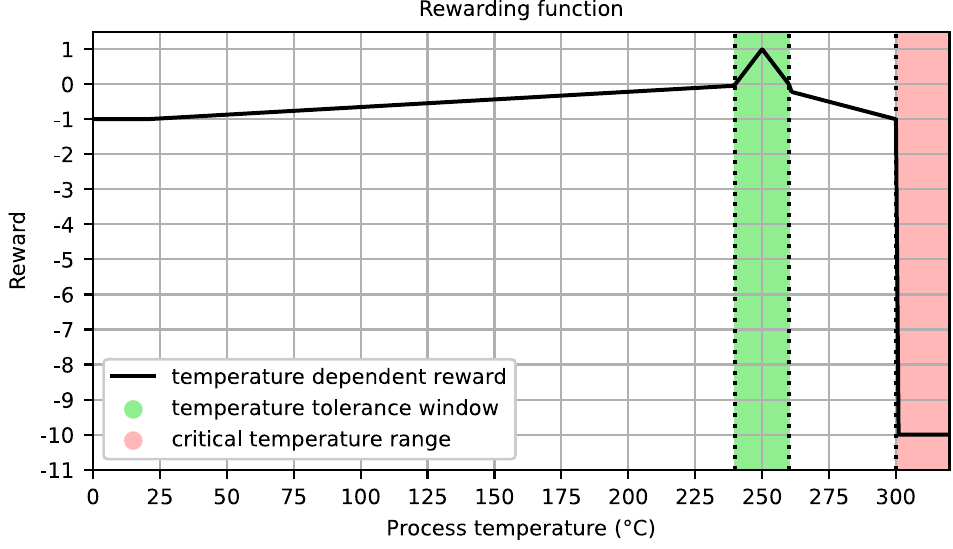
Figure 4. Given reward according to different temperature ranges. A positive reward is given to the agent when the temperature is kept within the tolerance range. The maximum reward is given when the target temperature is reached. Outside the tolerance zone, the reward falls linearly, with a higher degree of punishment in the higher temperature range as the material is more degenerated. A particularly high punishment of − 10 is given when T p = 300 °C is reached or exceeded to instill in the agent a high aversion to this temperature range. The room temperature of 20 °C is set as the lowest temperature limit. The reward is thus calculated